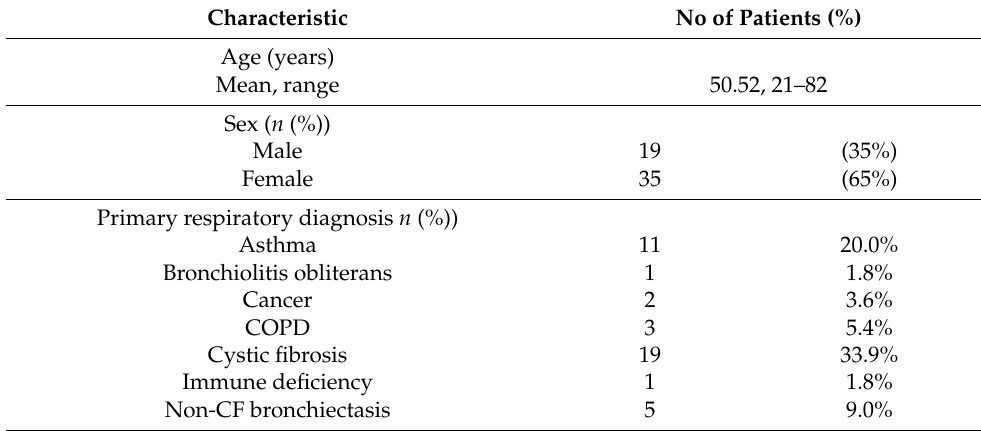
Table 1. Patient Demographics; n =